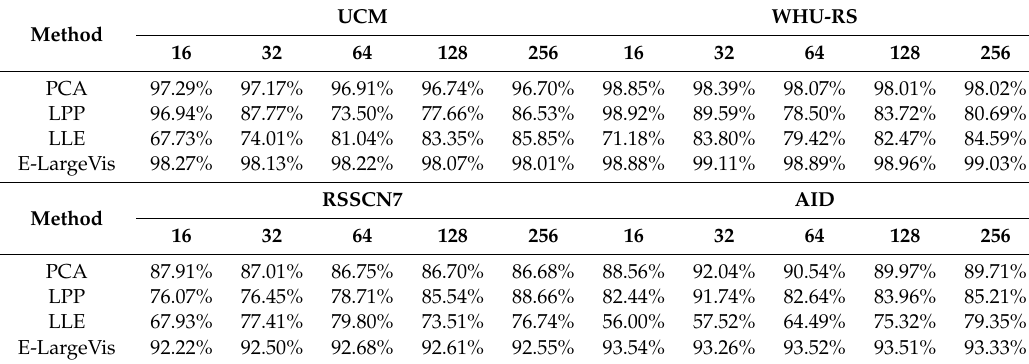
Table 5. Performance comparison of E-LargeVis and other dimensionality reduction methods.